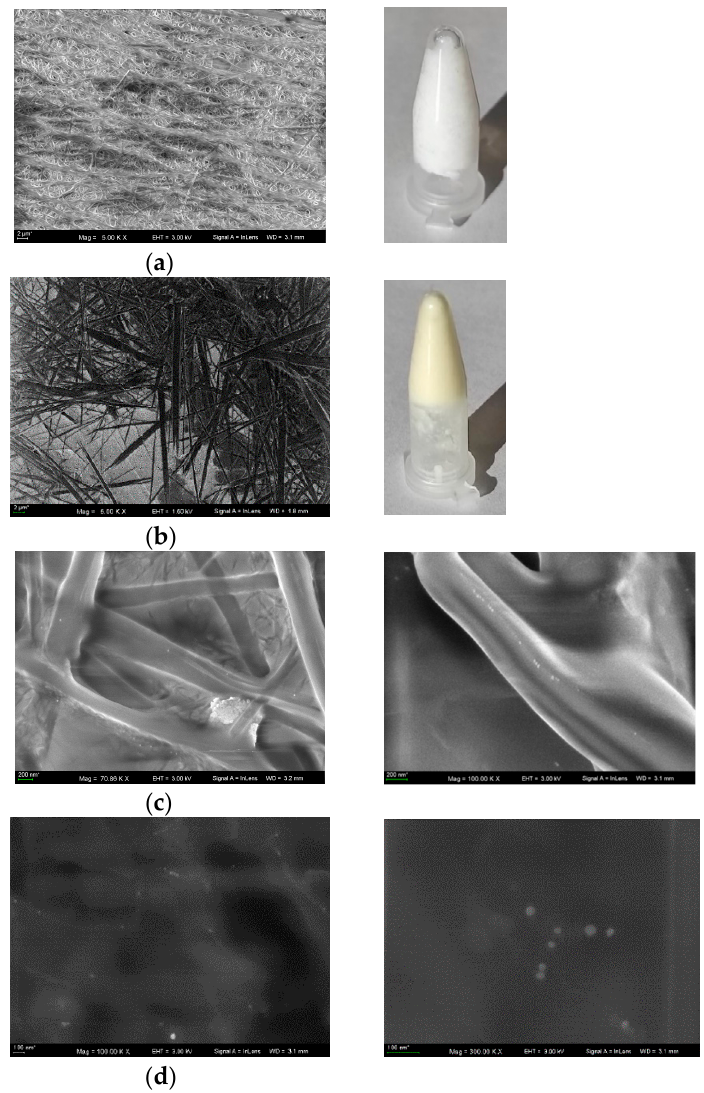
Figure 5. The SEM images of hydrogels. ( a ) hydrogel without AgNPs; ( b ) hydrogel with AgNPs; ( c ) SEM images of AgNPs distributed among the fibers of gel in two magnificstions; ( d ) SEM images AgNPs in melted gel in two magnificstions.